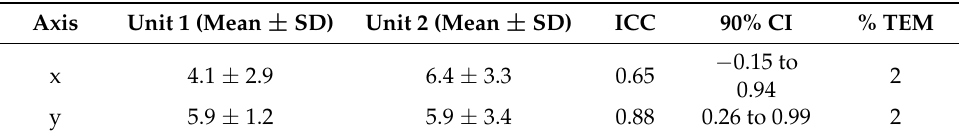
Table 2. Inter-unit reliability of x- and y-position coordinates. Axis Unit 1 (Mean ±